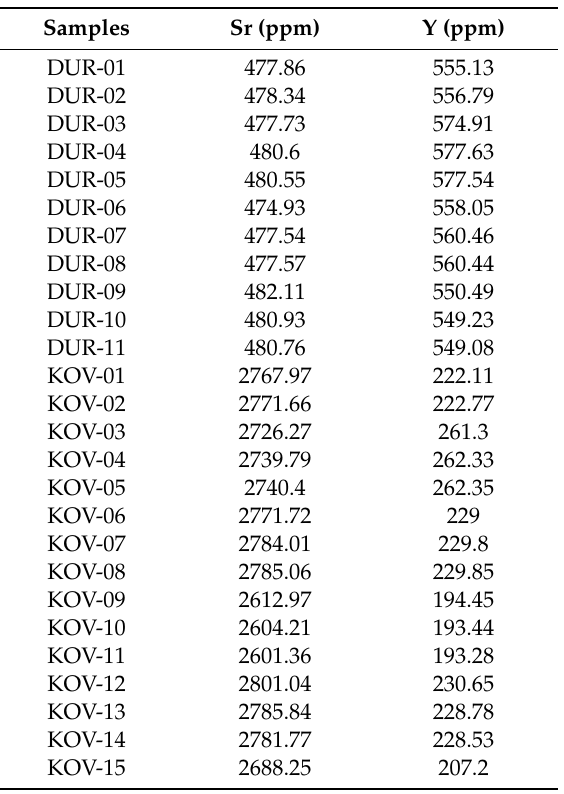
Table 3. The Sr and Y content of